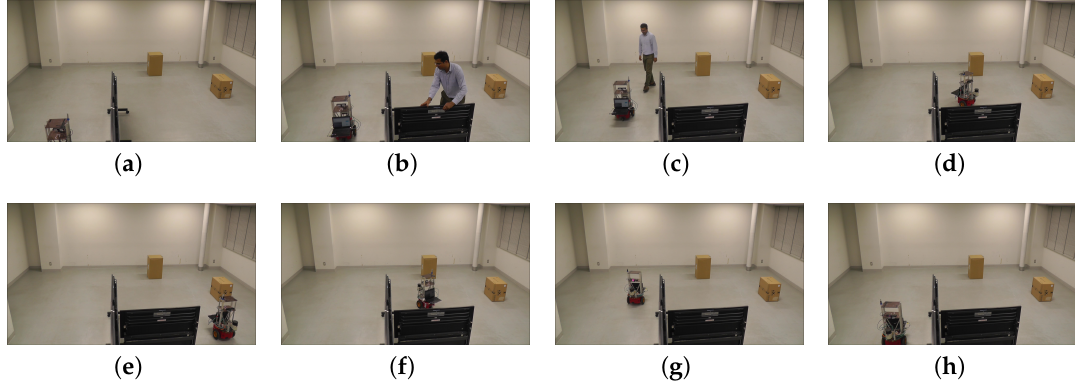
Figure 10. Timely snapshots of the experiment. ( a ) P3DX starts moving with old map. ( b ) Person adds a new obstacle. ( c ) Person moves in front of P3DX. ( d , e ) P3DX observes the new obstacle, changes trajectory and updates map. ( f – h ) P3DX return to the starting position. (Supplementary